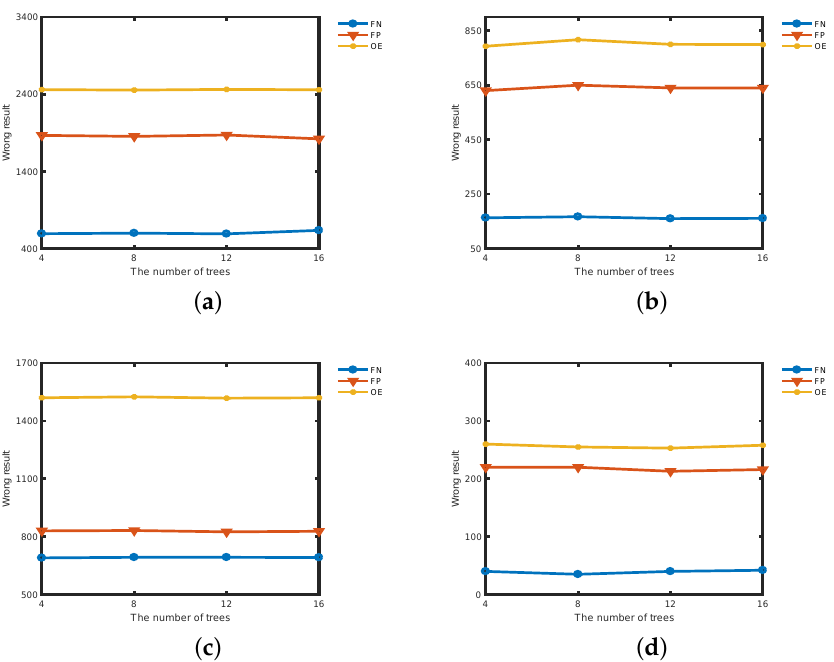
Figure 22. The wrong results on the different numbers of trees in the multi-grained scanning of four types of data. ( a ) Farmland D data set. ( b ) Farmland C data set. ( c ) Inland water data set. ( d ) Coastline data set.